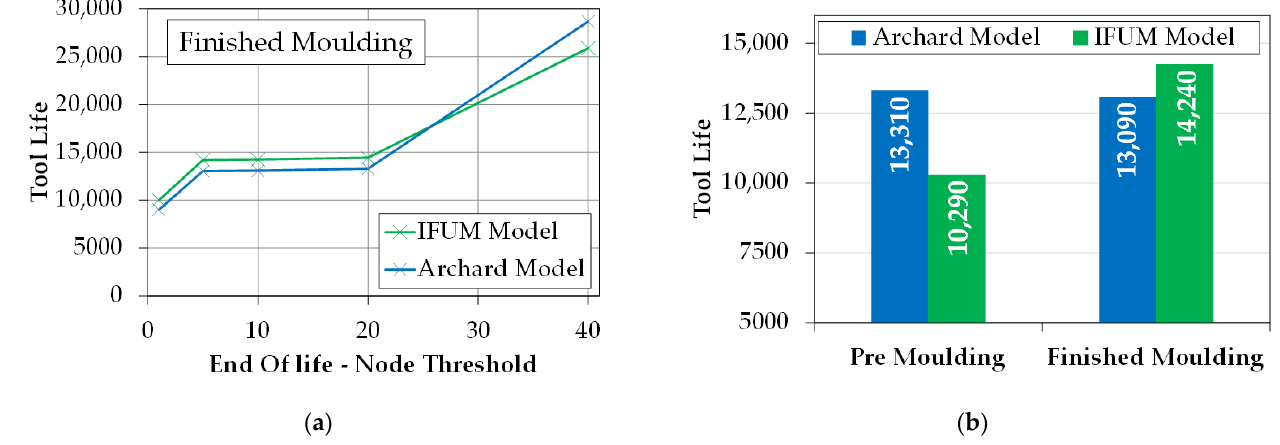
Figure 13. ( a ) Influence of the end of life determining node threshold on the tool life; ( b ) Expected tool life of both forming stages with model comparison to the Archard model ( H = 480; HV = const.), Node threshold = 20, acceptable wear depth = 2 mm.